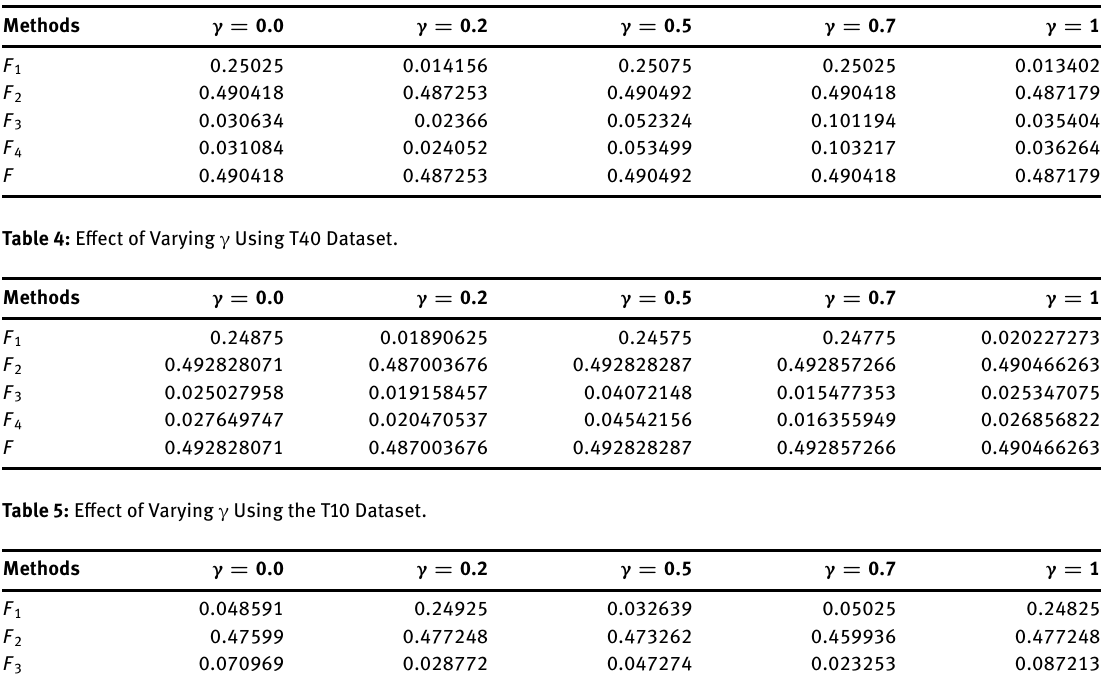
Table 3: Effect of Varying γ Using Retail Dataset.